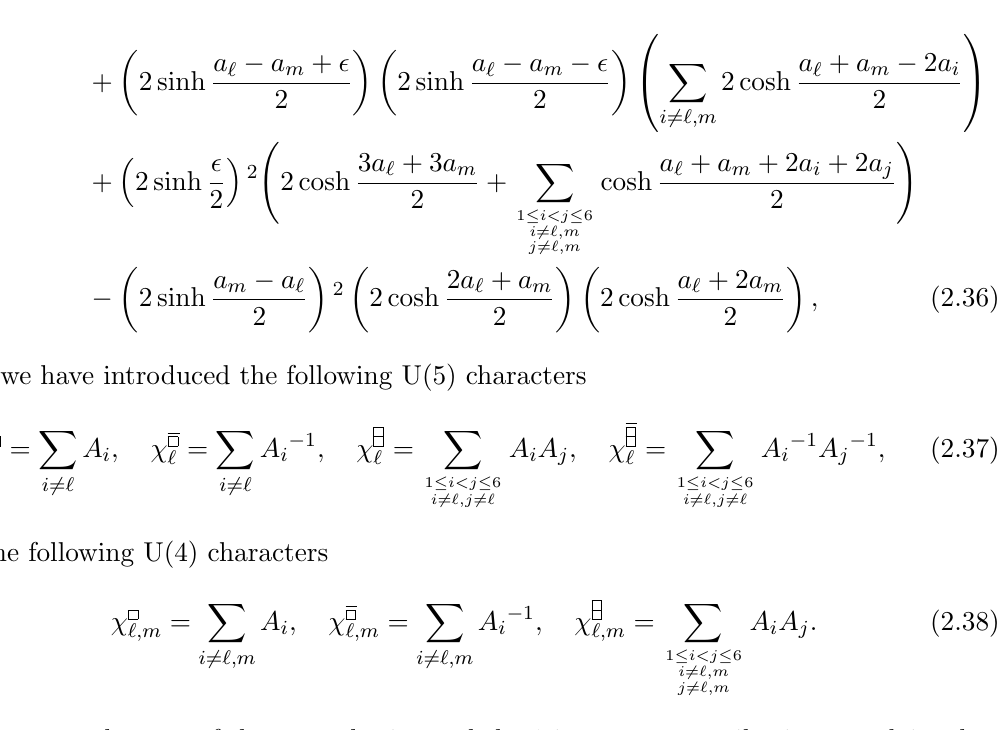
Figure 7 . (a) A 5-brane diagram realizing the SU(6) 5 obtained after shrinking red lines in (cid:12)gure